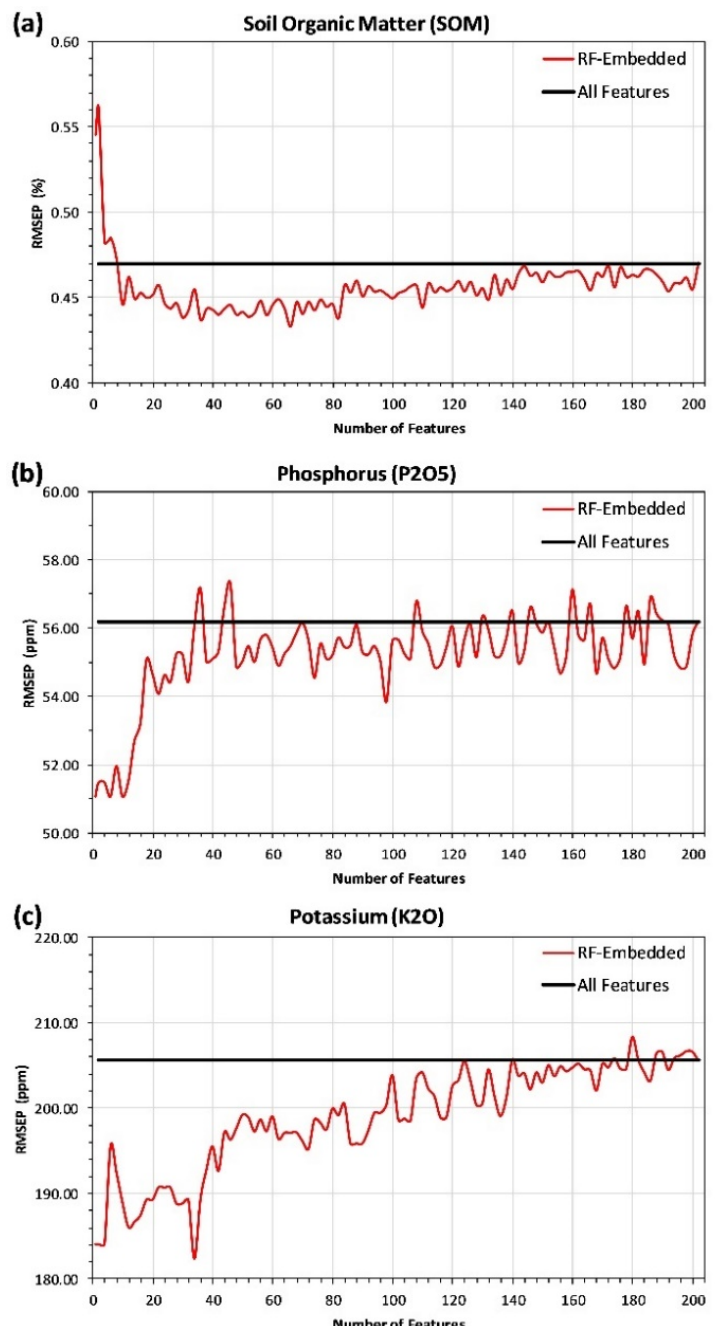
Figure 5. RMSEP values versus the number of features ranked by RF-embedded technique for the soil nutrient models: ( a ) soil organic matter (SOM), ( b ) available soil phosphorus (P 2 O 5 ), and ( c ) available soil potassium (K 2 O). The horizontal line represents the model, including all features used in the prediction.